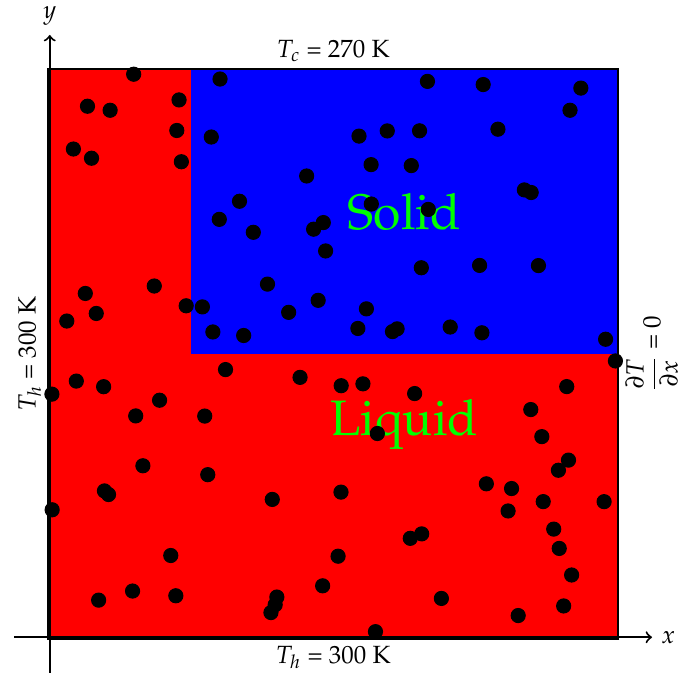
Figure 1. The geometry of the